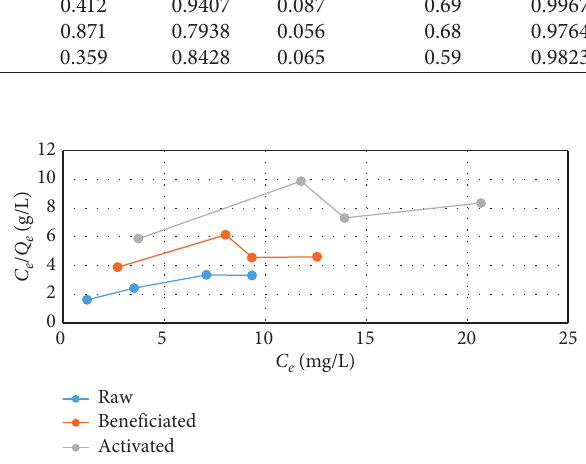
Figure 11: Langmuir isotherm model for different adsorbents (raw, beneficiated, and activated ash) at constant dosage 25mg/L, pH optimum 8 for raw and 12 for beneficiate and activated ash, contact time 100 min, shaker speed 100 rpm, room temperature, and concentration 25–100mg/L within 25 mg/L intervals.